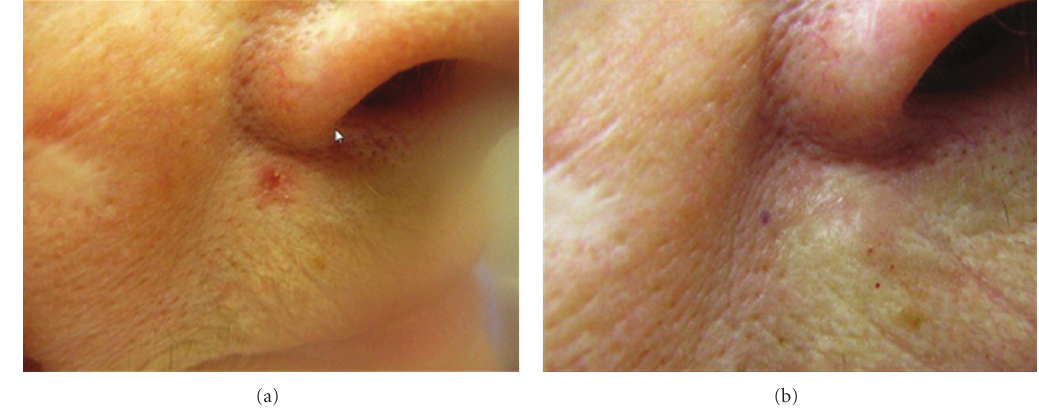
Figure 3: BCC in the right upper lip, before and three months after PDL treatment. Complete resolution of the lesion.